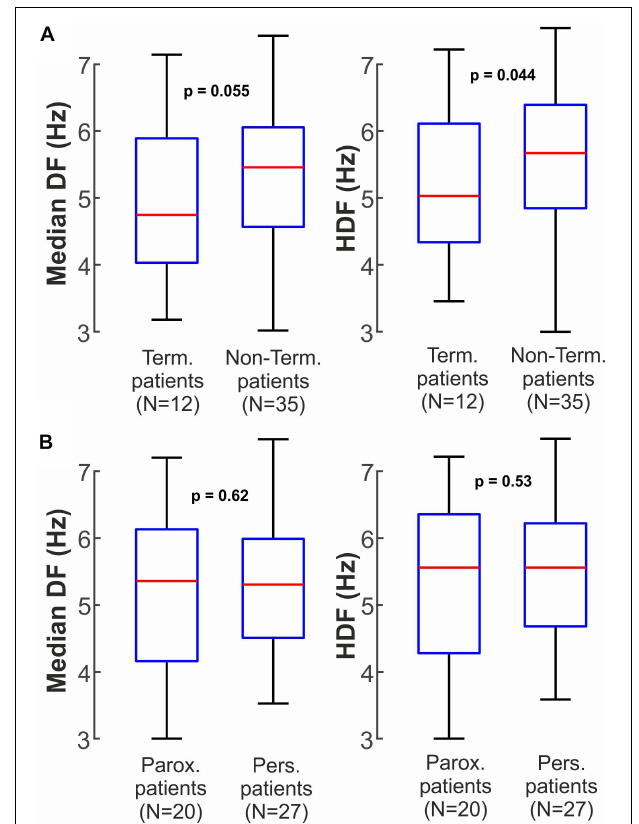
FIGURE 5 | Non-invasive clinical Dominant Frequency measures between different patient groups. (A) Median DF and HDF for patients in which ablation did or did not terminate AF. (B) Median DF and HDF for paroxysmal and persistent AF